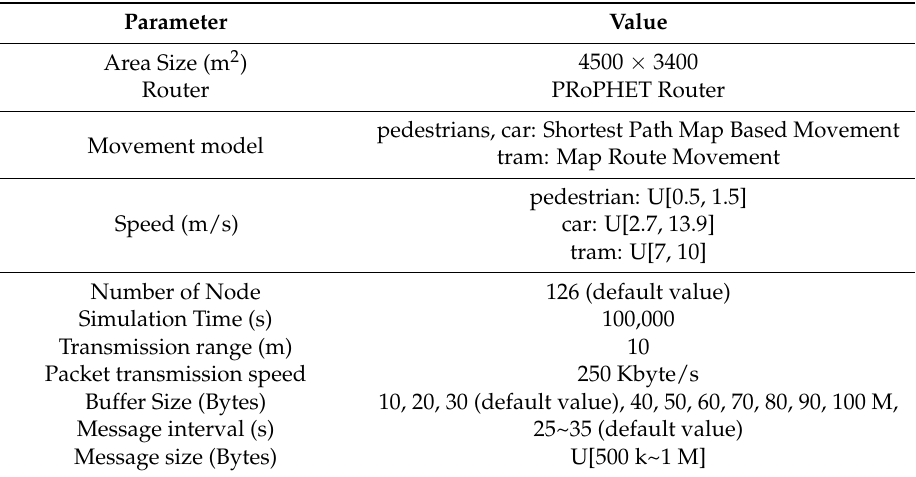
Table 1. Simulation Parameter